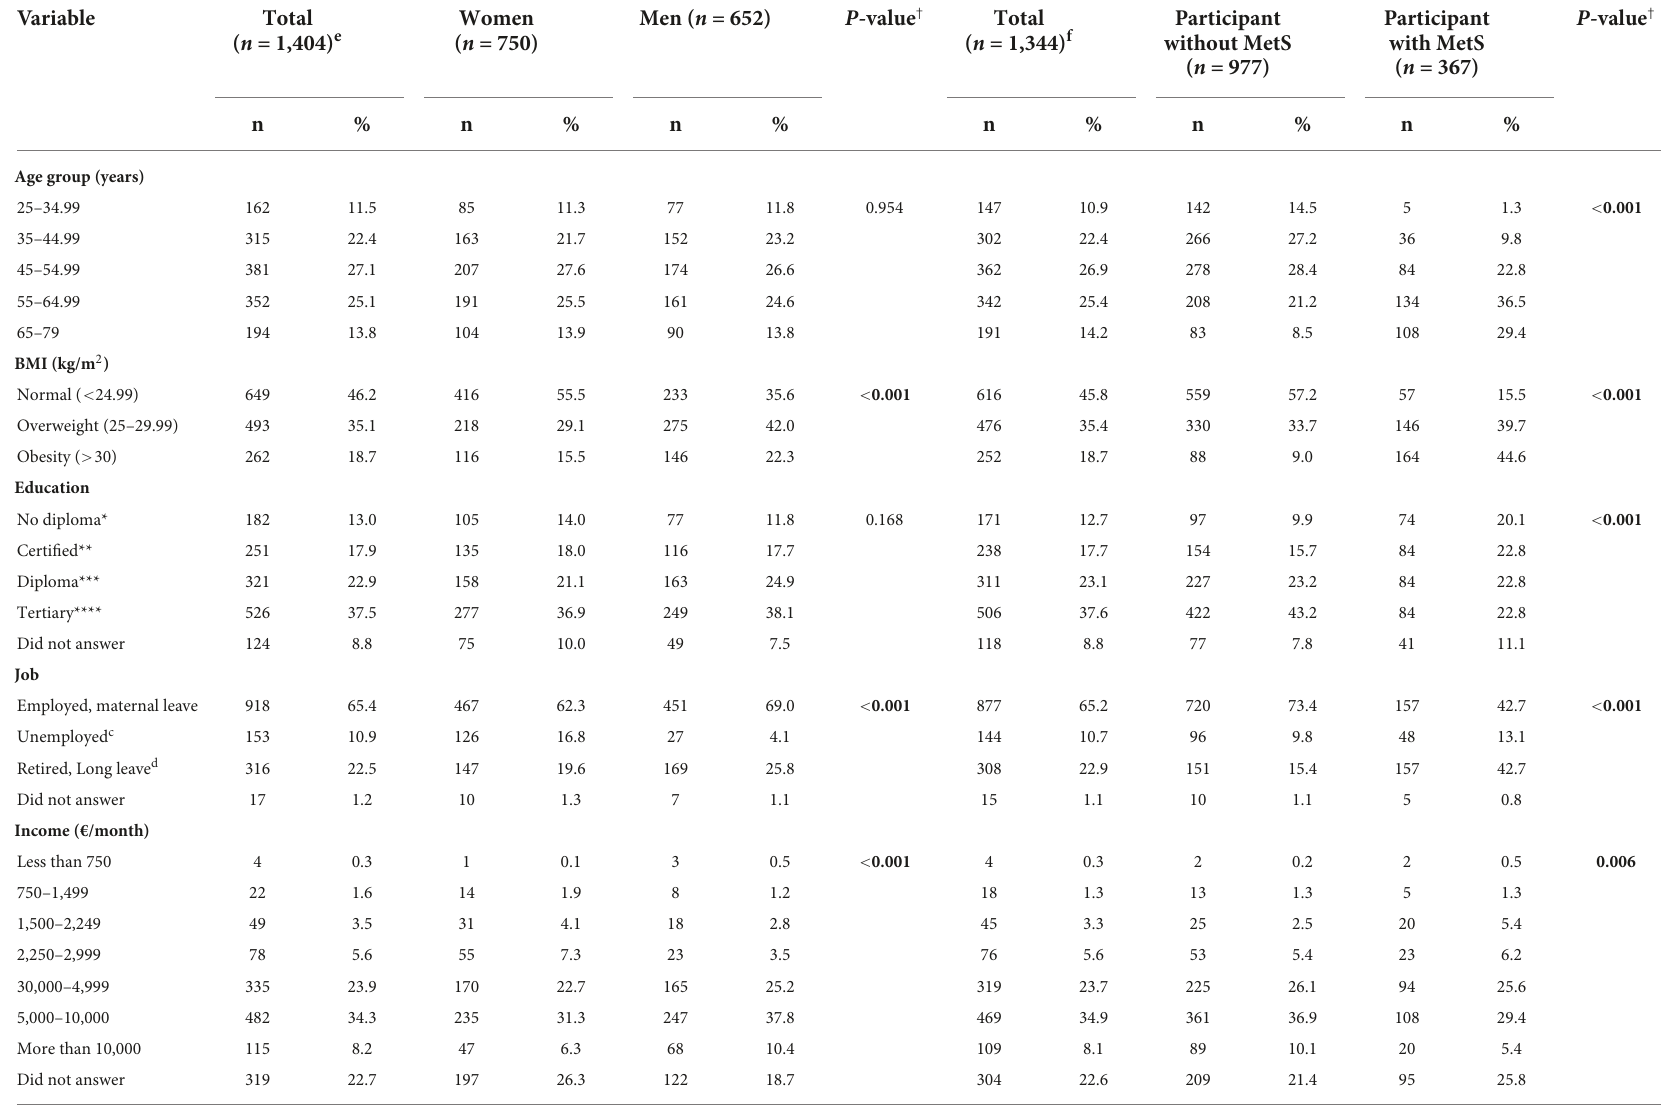
TABLE 1 Distribution of demographics, anthropometric and socioeconomic characteristics of participants based on gender and MetS status, presented as frequency, percentage, and P -values, comparing women vs. men and participants without MetS vs. participants with MetS.